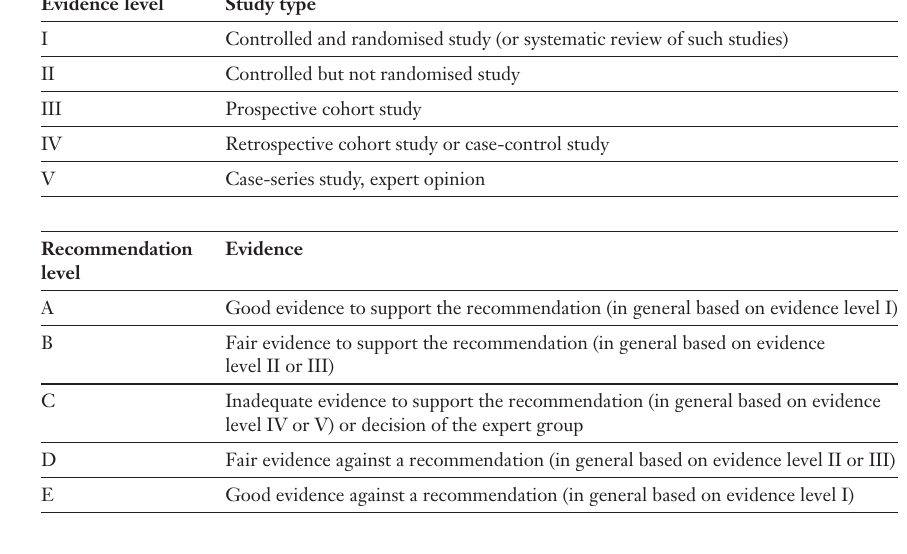
Complications of